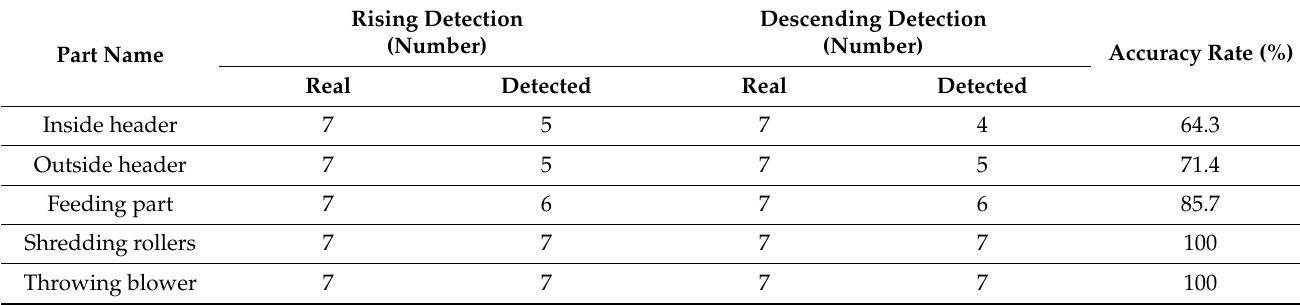
Table 1. Results of boundary detection for data filtering. Table 2. Pre-processed data of field